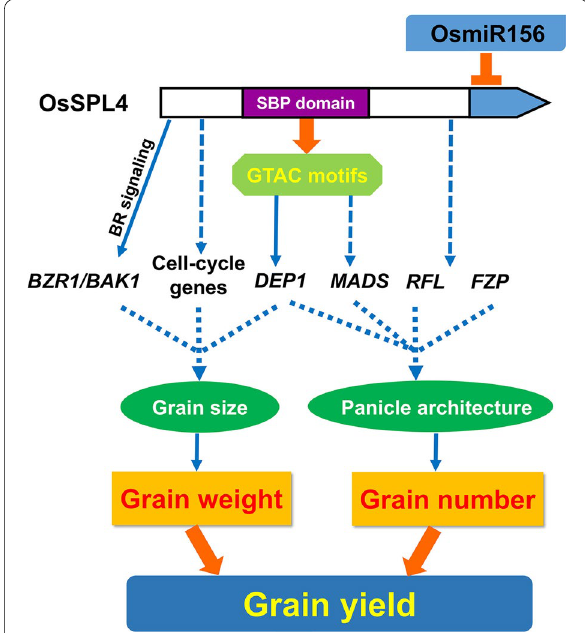
Fig. 9 Aproposed model for the regulation of grain yield by OsSPL4 in rice. Arrows indicate the positive effects and short horizontal lines represent the negative effects. The dashed lines indicate the molecular mechanisms which are unclear. BR,